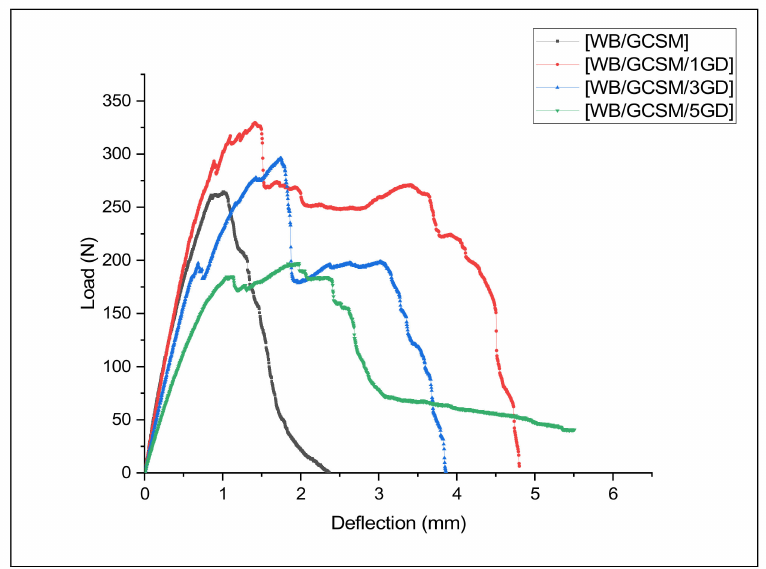
Figure 9. Typical ILSS load-deflection curves for [WB/GCSM], [WB/GCSM/1GD],